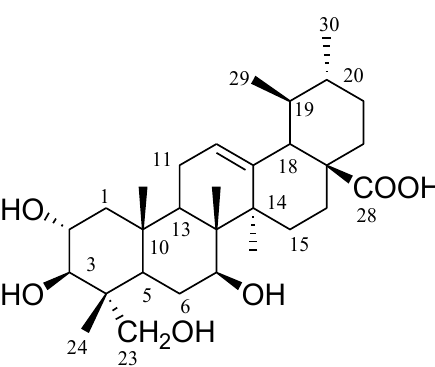
Figure 1. Chemical structure of compound 1 (2 α ,3 β ,7 β ,23-tetrahydroxyurs-12-ene-28-oic acid).